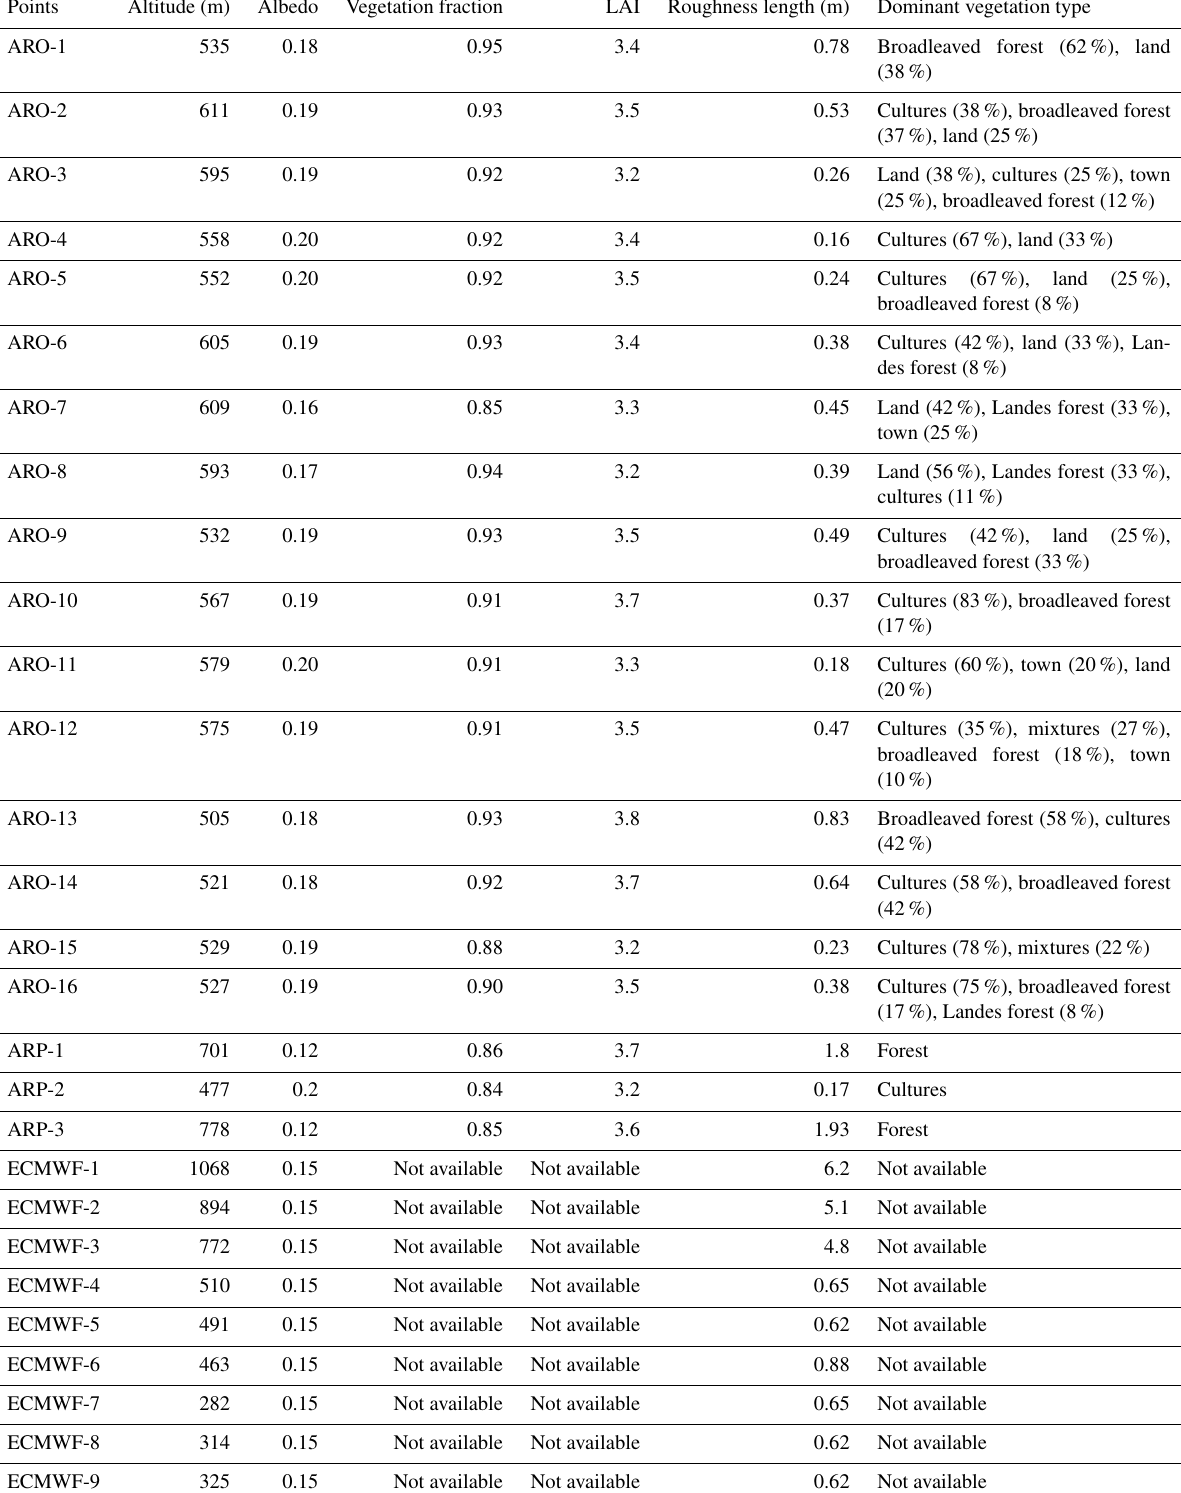
Table 3. Surface characteristics of the various points extracted from the models: the surface characteristics, i.e. albedo, vegetation fraction (the complementary being bare soil), leaf area index (LAI) and roughness length correspond to the total value for the grid point. In ARPEGE and ECMWF the roughness length takes the subgrid orography into